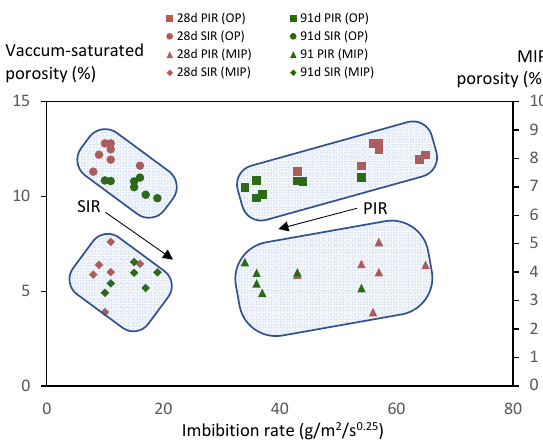
Figure 6. Relation between open OP and PIR and SIR at 28 and 91 days (from mixes OPC, SB20/40/60, FA20/30/40); and between MIP intrudable porosity and PIR and SIR at 28 and 91 days (from mixes SB20/40/60, FA20/30/40). The values of the relative accessible porosity occupied by water entering the sample at the end of the primary capillary imbibition period in Mixes 1 ‐ 4 after 28 and 91 days of curing are shown in Figure 7. The relative volume corresponds to the average of the (vacuum ‐ saturated) porosity filled by water at the end of the primary imbibition period (error bars indicate the standard deviation, n = 5). The moisture content reached at the end of the primary period was calculated considering the fourth root of time approach. The total porosity is around 50 % filled, which indicates that almost all capillary pores are filled at the end of the primary imbibition period.